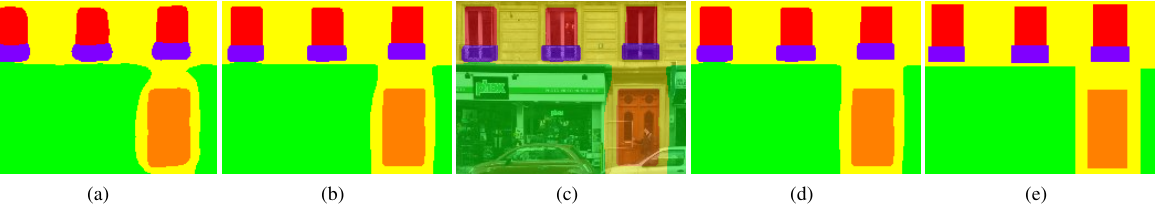
Figure 5. Iterative delineation. Image (a) results from the Structured Random Forest. (b) gives results after 10 iterations, (c) results after 10 iterations mapped into the input image, (d) results after 50 iterations and (e) ground truth. One can observe that the object delineation is very accurate even after only the 10th iterations. Colors see Fig.